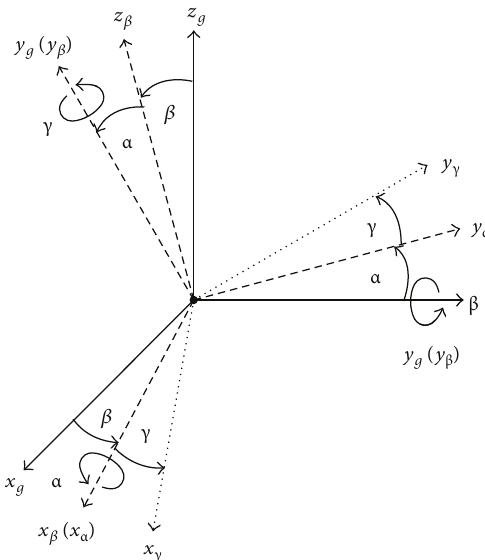
Figure 10: Euler angles of the rocking motion of the fl ywheel and the